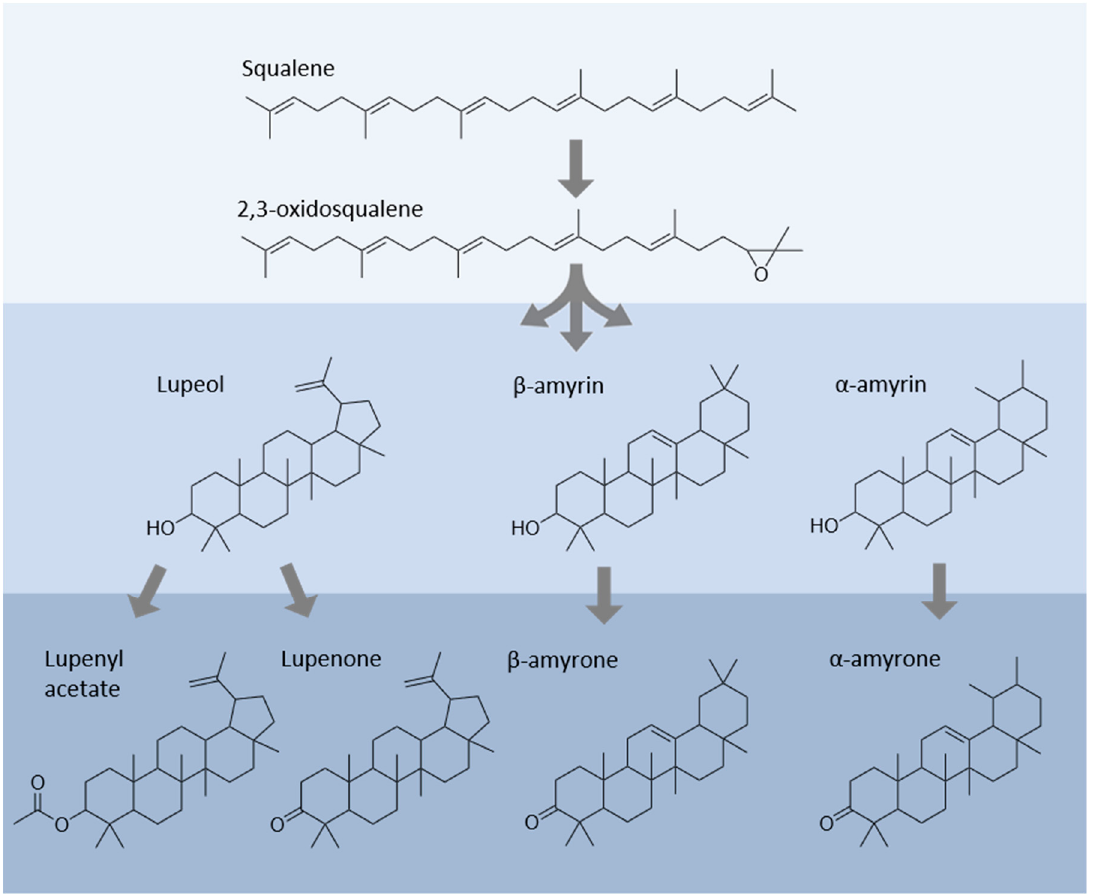
Figure 6. Scheme representative of synthesis pathways of triterpenoids from squalene, namely the lupane, oleanane and ursane series.